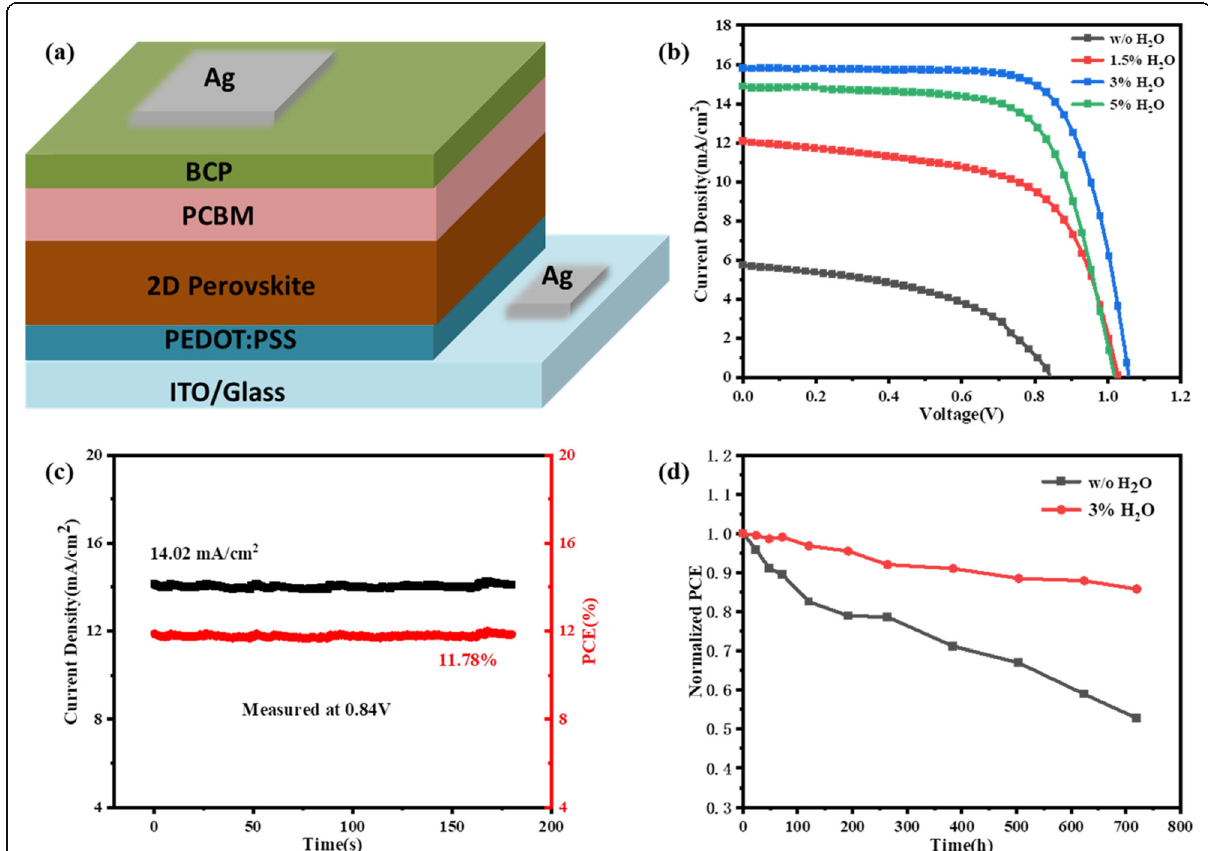
Fig. 1 a Schematic illustration of PVSC structure. b J-V curves of PVSCs based on BA 2 MA 3 Pb 4 I 13 films deposited from perovskite precursor solutions doped with different volume H 2 O. c Steady-state photocurrent and PCE of the champion device 1 sun condition. d Long-term stability of the unsealed device without and with 3% H 2